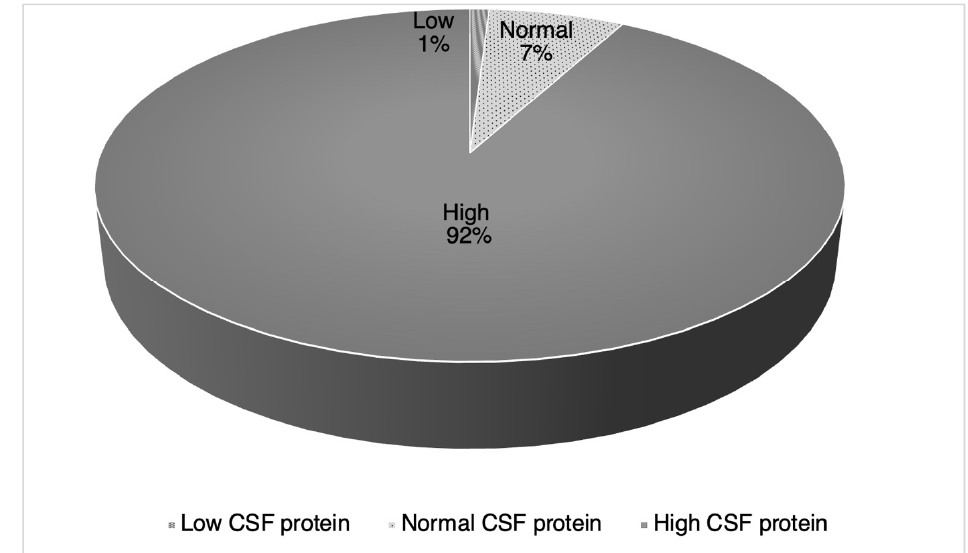
Figure 2. Cerebrospinal fluid protein values.